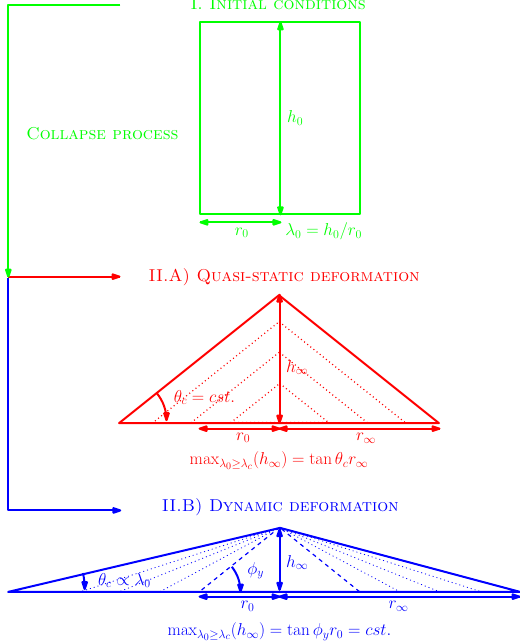
Figure 1. The general scheme of hypothetical quasistatic deformations and the actual experimental evidence of dynamic deformations leading to a constant h ∞ . The dotted lines correspond to increasing volumes with respect to an increasing λ 0 . In Case II B (dynamic deformations), θ (cid:48) c naturally decreases as λ 0